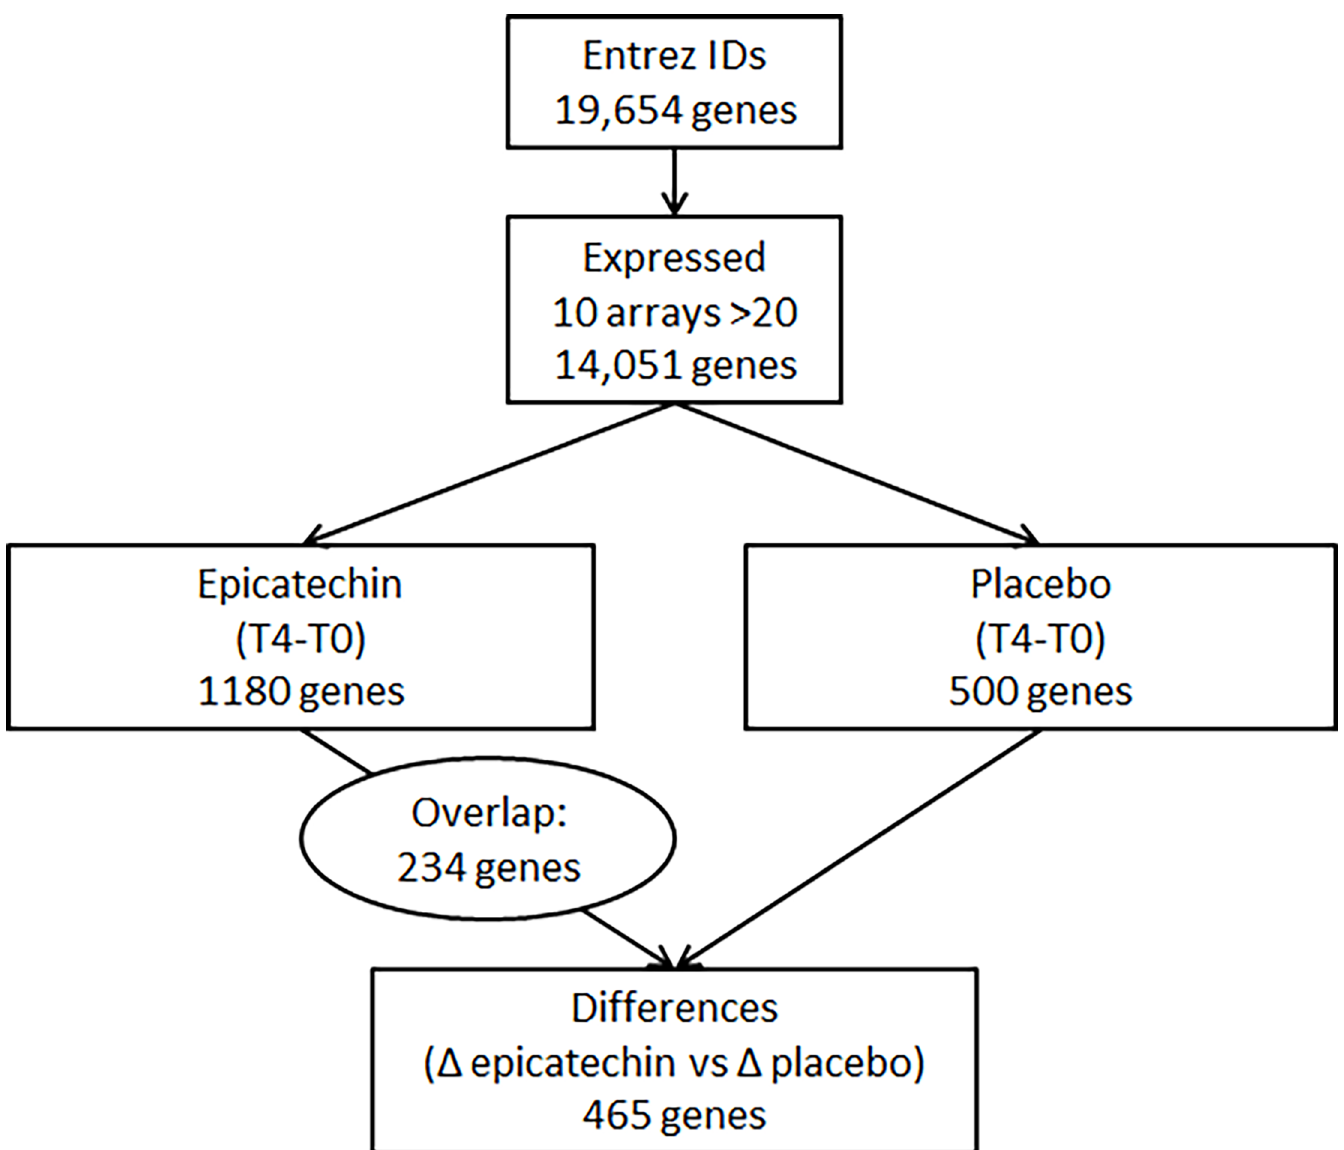
Fig 2. Flow diagram showing the number of genes of which the expression was changed after 4-week epicatechin or placebo supplementation and the number of genes that significantly changed in expression between the epicatechin or placebo intervention. A change was considered significant if two-sided P < 0.05.